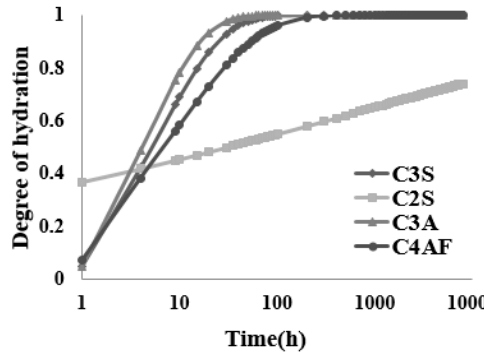
Figure 3. Hydration rates of main constituents of Portland cement